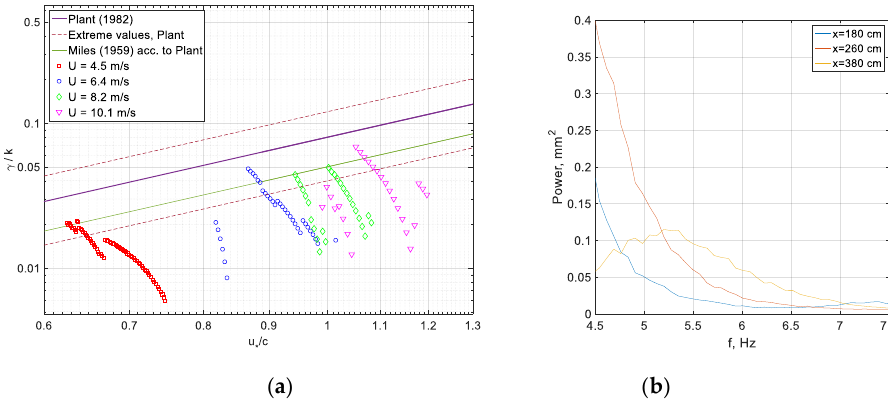
Figure 31. ( a ) Symbols–dimensionless spatial exponential growth rates under steady wind forcing estimated from experiments for different frequency spectral harmonics, lines–empirical fit by Plant [104] and Miles [23] theory; ( b ) Measured spectra at U = 7.5 m/s and three fetches.